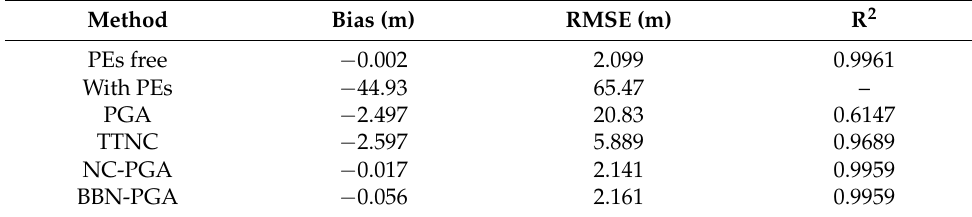
Table 2. Evaluation results of simulated experiments.